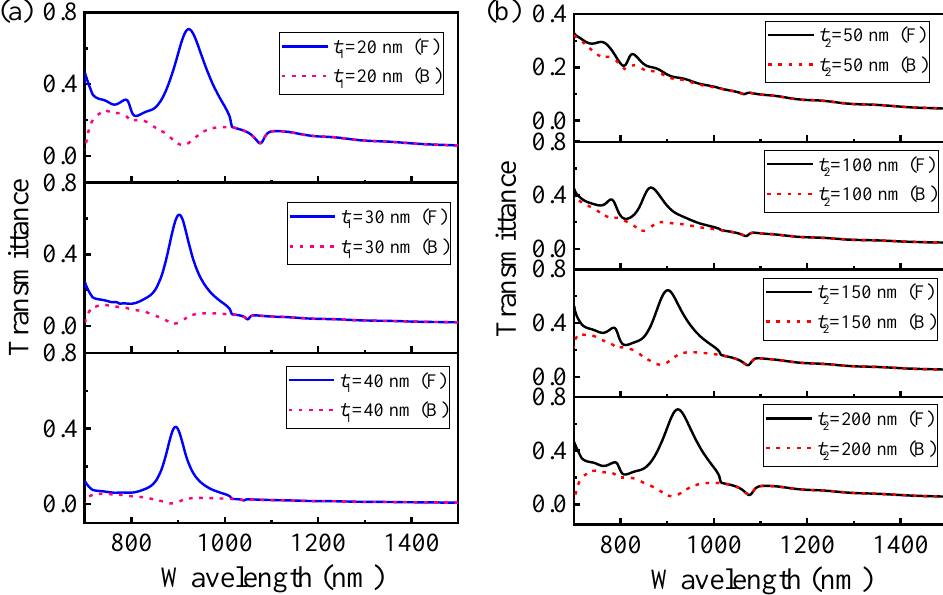
Figure 6. Forward (F) and backward (B) transmittance spectra for different geometric parameters. ( a ) Au layer thickness t 1 ; ( b ) dielectric disk thickness t 2 .